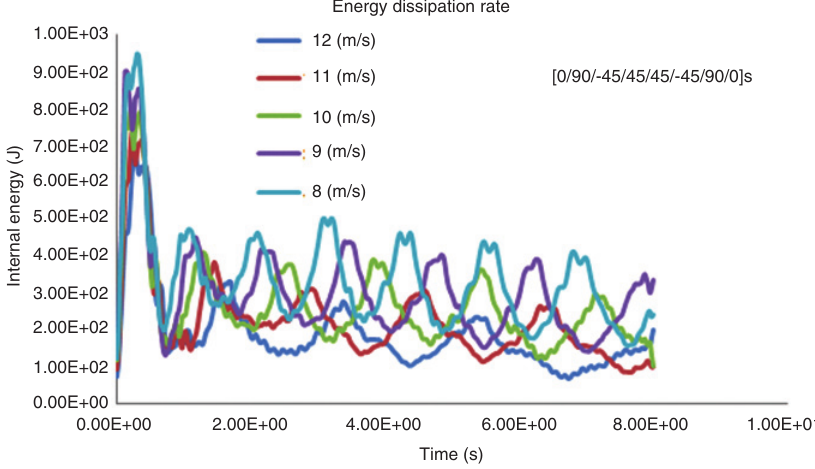
Figure 10 Energy dissipation rate of the stacking sequence of [0/90/-45/45/45/-45/90/0]s at various impacting